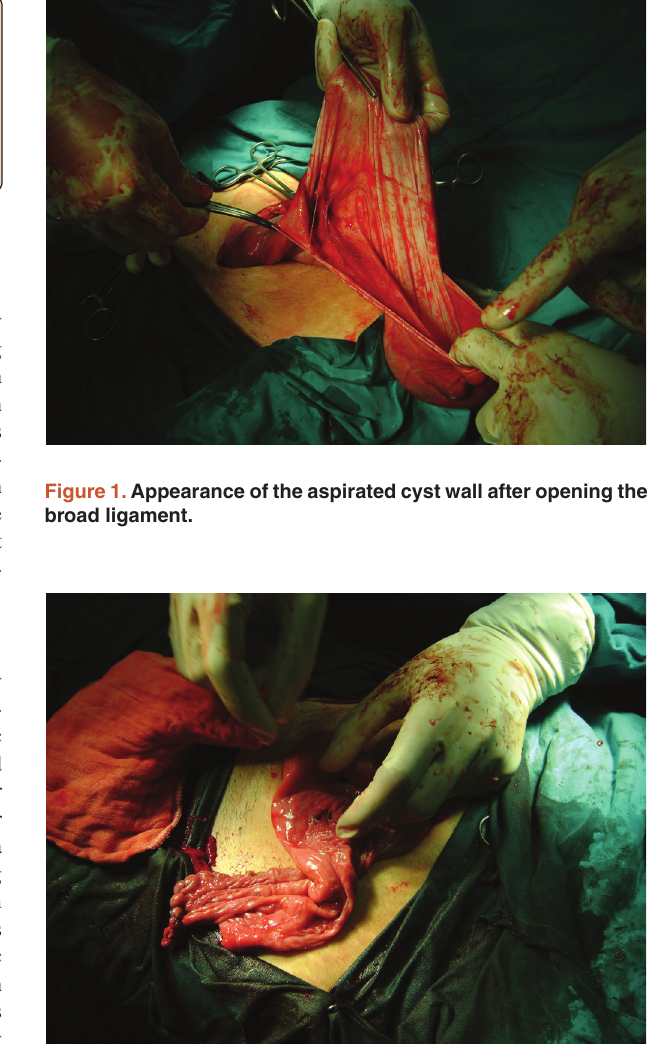
Figure 2. The final shape of the left broad ligament after its reconstruction with intact